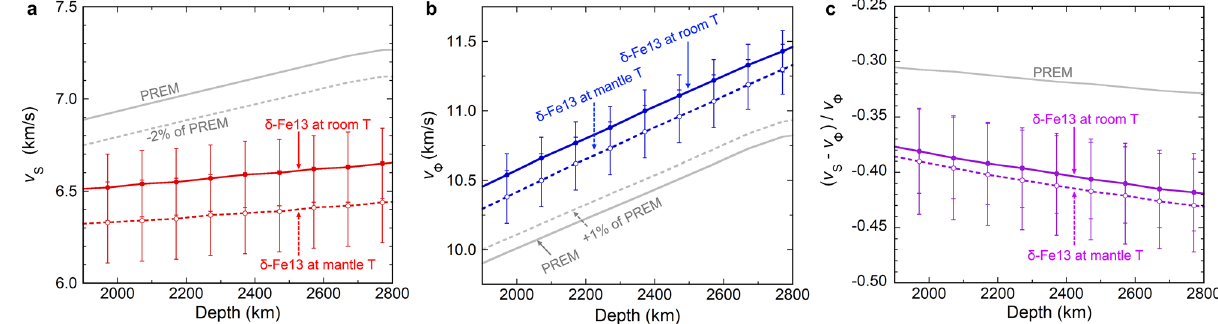
Figure 4. The depth–velocity profiles of δ-Fe13 and PREM 36 : (a) v S , (b) v Φ , and (c) ( v S − v Φ )/ v Φ . The plots of δ-Fe13 at room T (solid circle) and mantle T (open circle) indicate the velocities of δ-Fe13 at room temperature and along an average mantle geotherm 48 , respectively. The calculation procedure of v S and v Φ of δ-Fe13 under these conditions is explained in the main text. The velocities of δ-Fe13 shown in this figure are determined using the density of δ-Fe13-r2 with natural mass of Fe. The dotted gray lines indicating − 2% of v S and + 1% of v Φ relative to PREM (solid gray lines) are regarded as reasonable perturbations for each respective velocity within the LLSVPs, based on the SB10L18 model 27 . The degree of anti-correlation between v S and v Φ in δ-Fe13 is considered to be larger than the maximum anti-correlation observed in the LLSVPs. Estimated uncertainties for δ-Fe13 are shown by the vertical bars. The numerical values for the data shown in this figure are available in Table